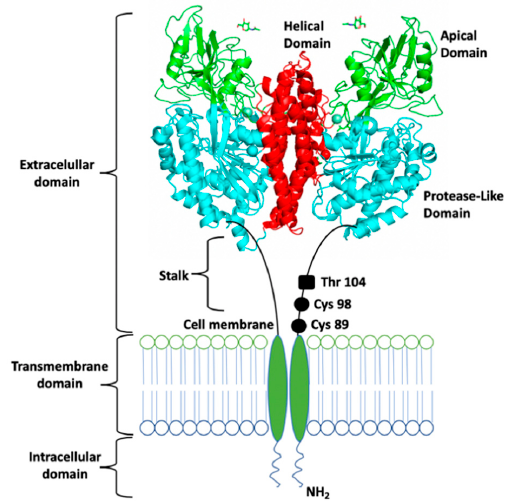
Figure 7. Schematic representation of the TfR. Figure shows the extracellular domain, with the stalk and the three subdomains (helical domain, apical domain, and protease-like domain), the transmembrane domain, and the intracellular domain. PDB code: 1CX8.